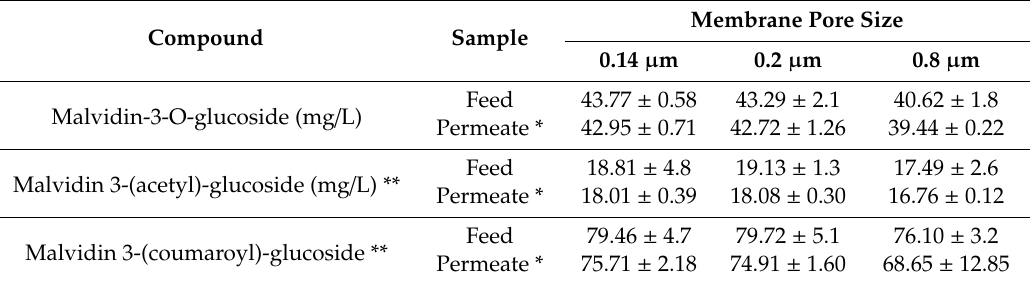
Table 4. Anthocyanins content in the feed and permeate stream of investigated membranes.